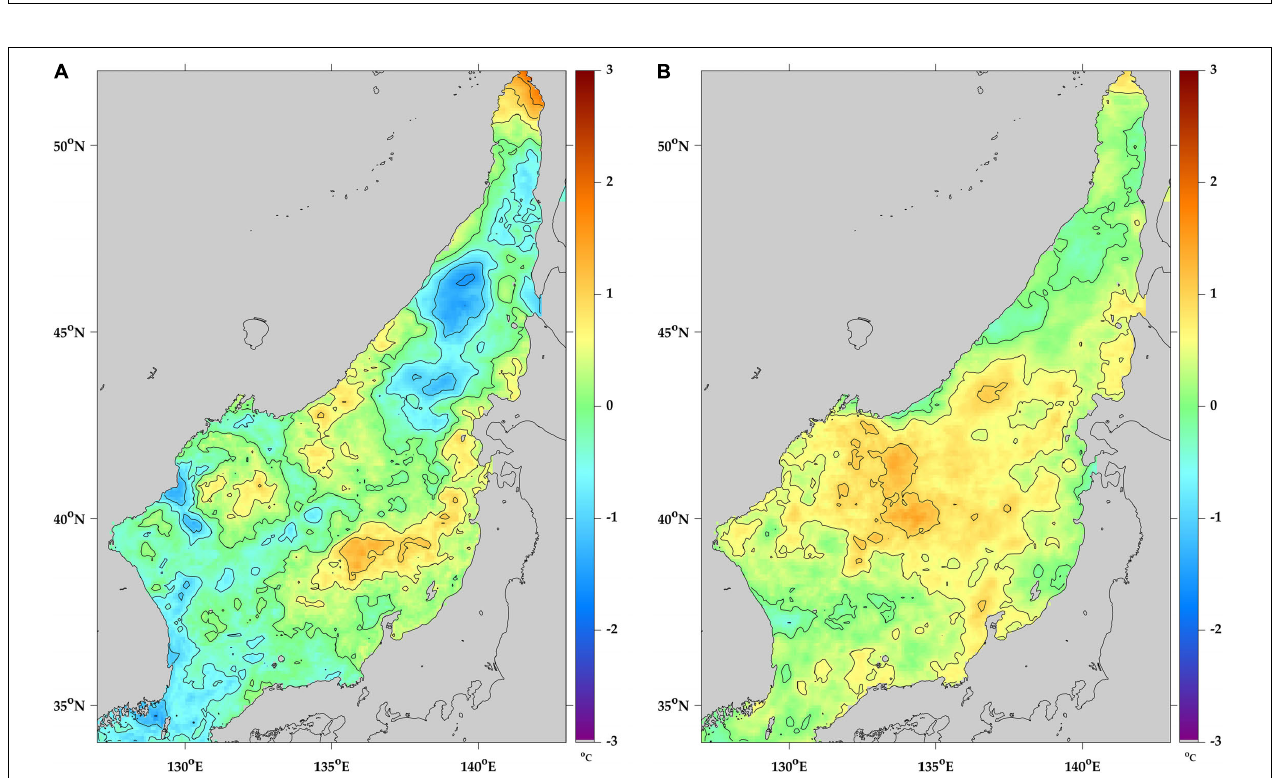
FIGURE 13 | Spatial distribution of sea surface temperature anomalies averaged for the periods of (A) El Niño (ENSO index > 1) and (B) La Niña (ENSO index < -1) in the East Sea (Sea of Japan) in summer (June–August) from 2003 to 2020.